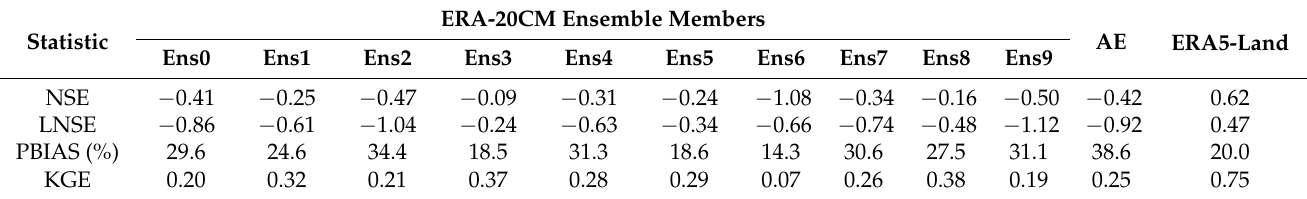
Table 5. Statistical results of hydrological validation with the ten ERA-20CM ensemble members, the AE, and the ERA5-Land from August 1973 to December 2010 in monthly time scale to